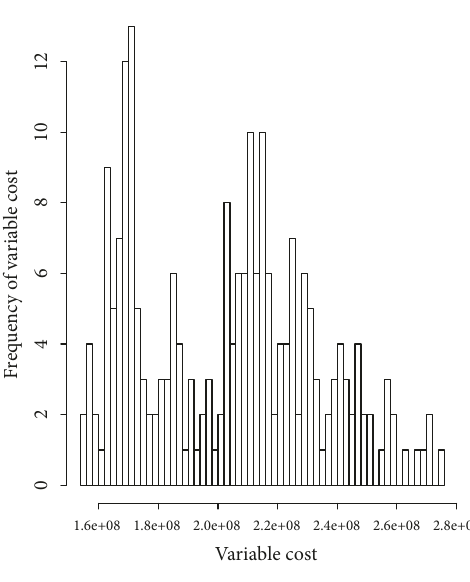
Figure 7: Distribution of variable costs,